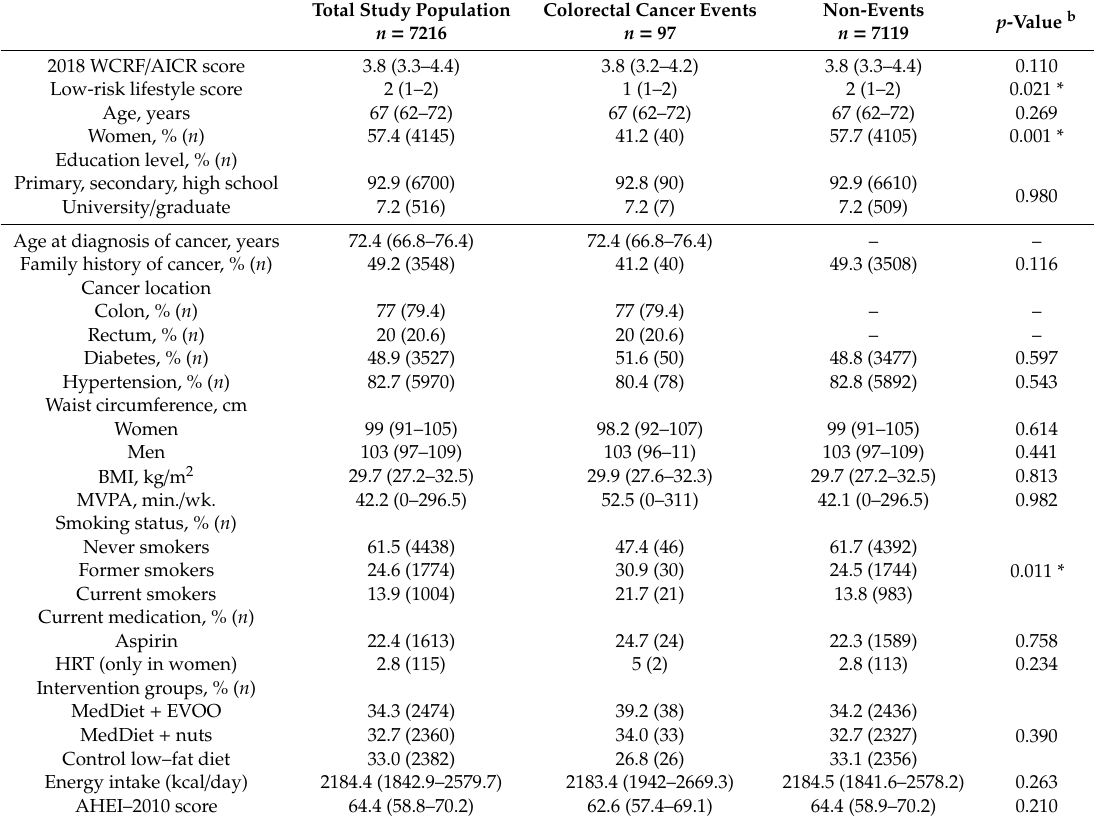
Table 1. Baseline characteristics of the study population in the PREvenci ó n con DIeta MEDiterr á nea (PREDIMED) study a